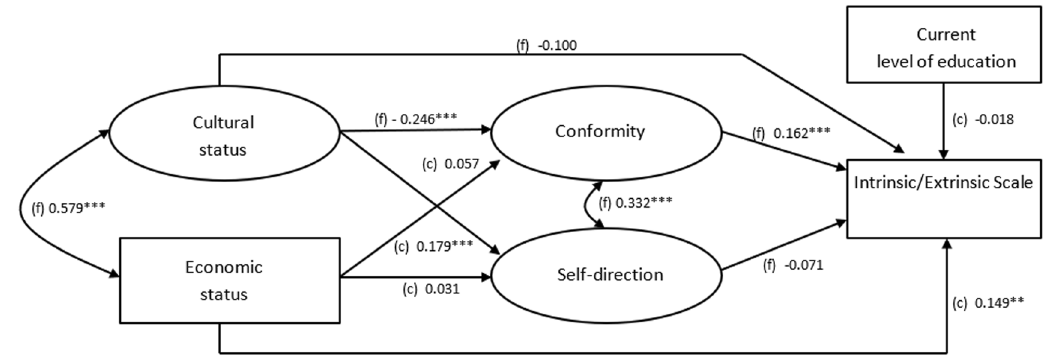
Fig. 2 Effects of parents ’ cultural and economic status and parenting values on the intrinsic/extrinsic scale for male adolescents. Note: ***p- value < 0.01 . **p -value < 0.05 . *p -value < 0.1 . (c) is a constraint path for male and female adolescents and (f) is non-constraint (free) path. Goodness of fi t: RMSEA = 0.00, CFI = 1.00 and TLI = 1.00.